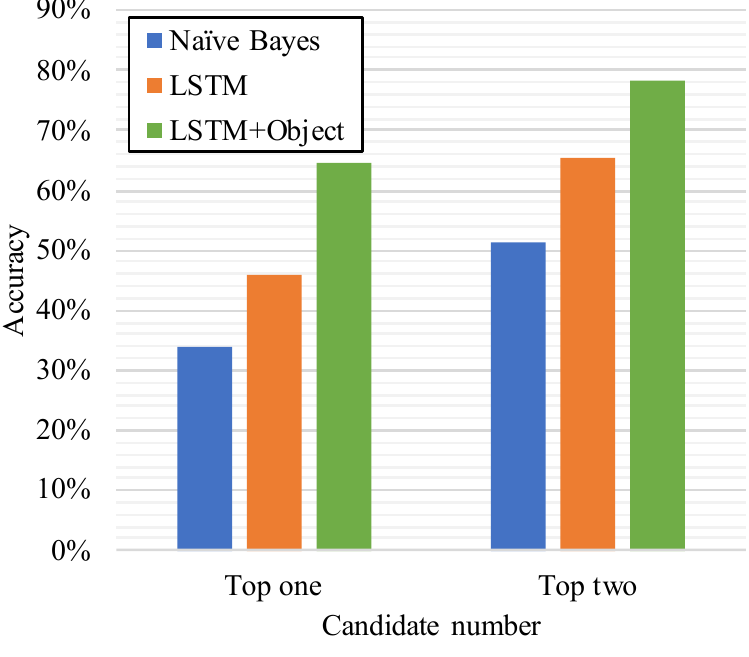
Figure 7. Accuracy of Naive Bayes and long short-term memory (LSTM)